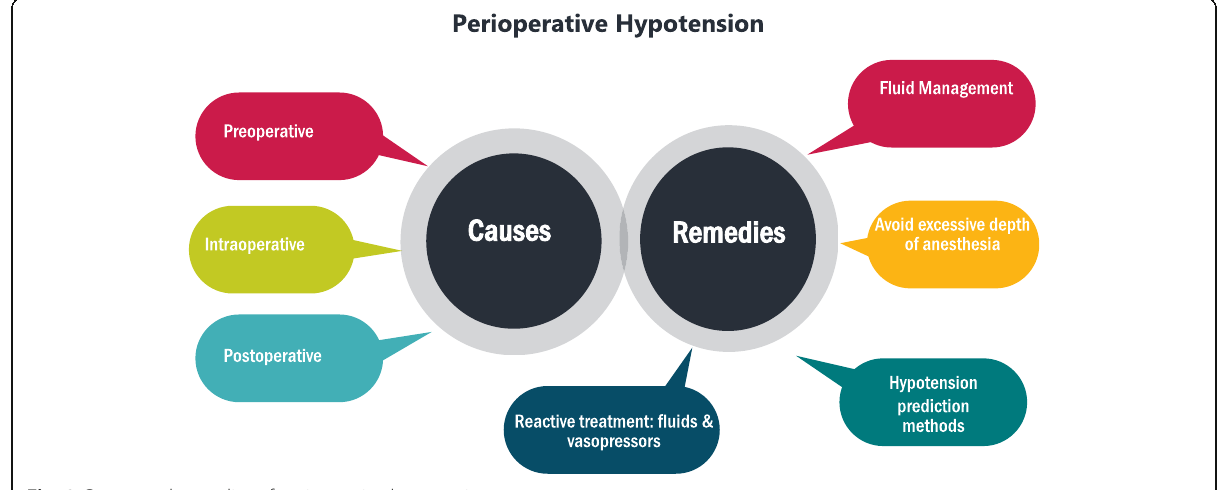
Fig. 3 Causes and remedies of perioperative